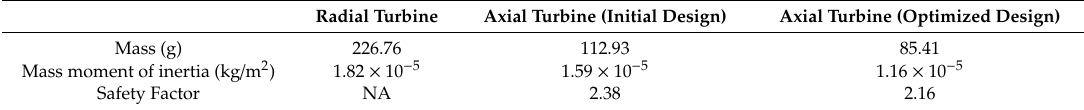
Table 11. Comparison of baseline radial, axial turbine, and optimised axial turbine